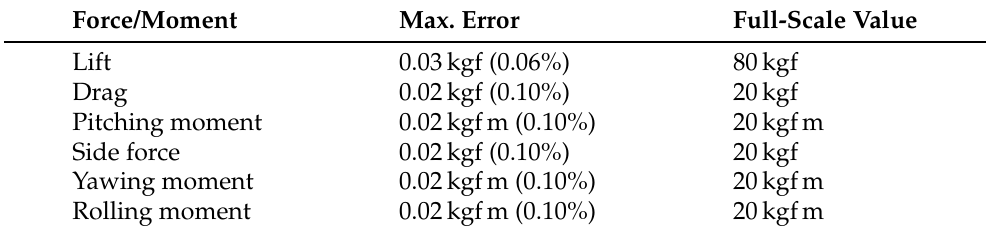
Table 2. Strain gage balances characteristics.